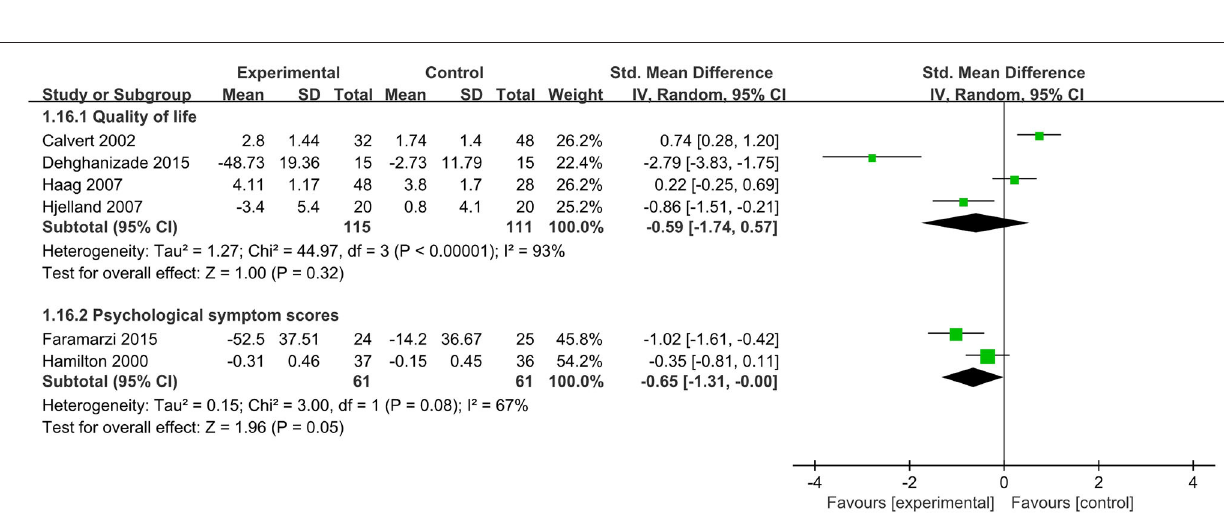
Psychological Interventions on